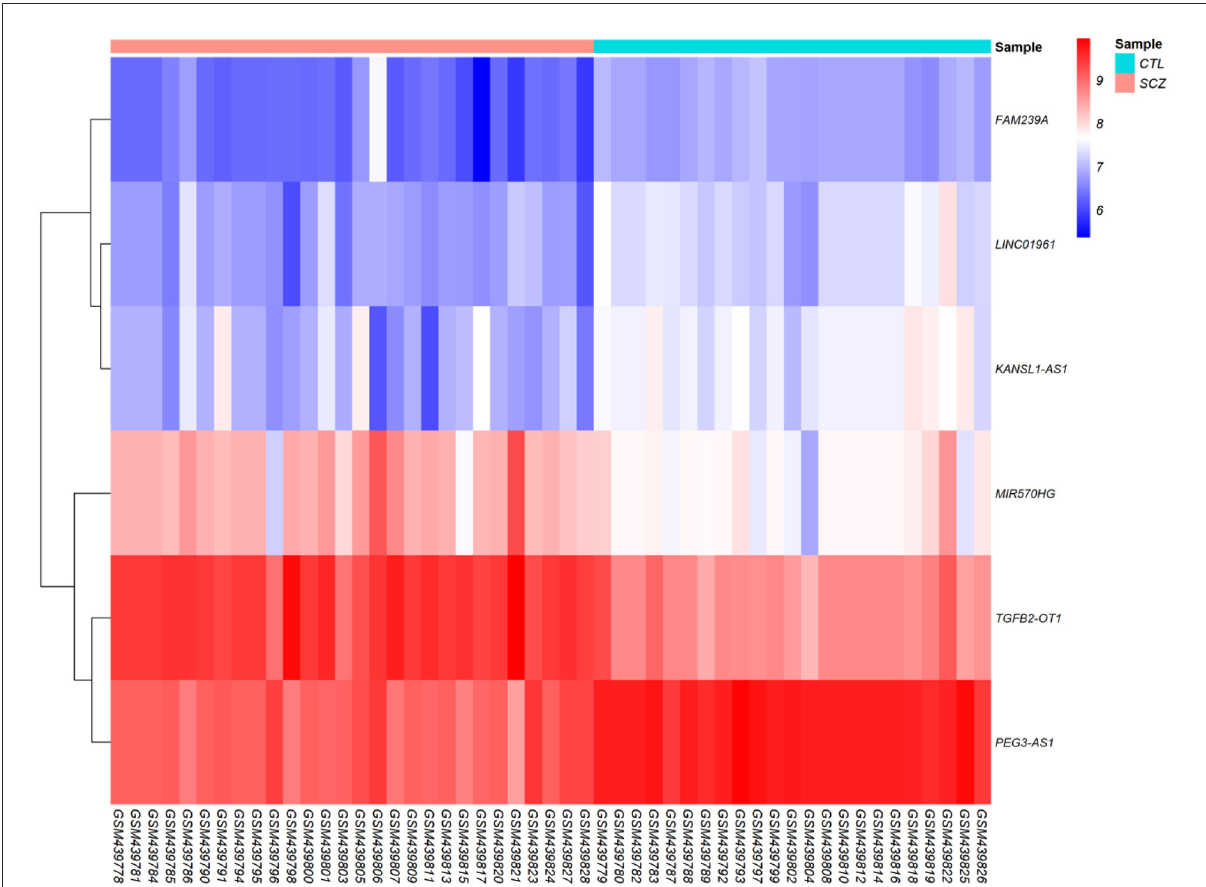
FIGURE2 Differentially expressed long non-coding RNAs (DElncRNAs) heatmap. The color values correspond to normalized gene expression data. The color and intensity of the boxes are used to reflect the expression level of DElncRNAs in each sample. The color blue shows those DElncRNAs with low expression, while red represents those with high